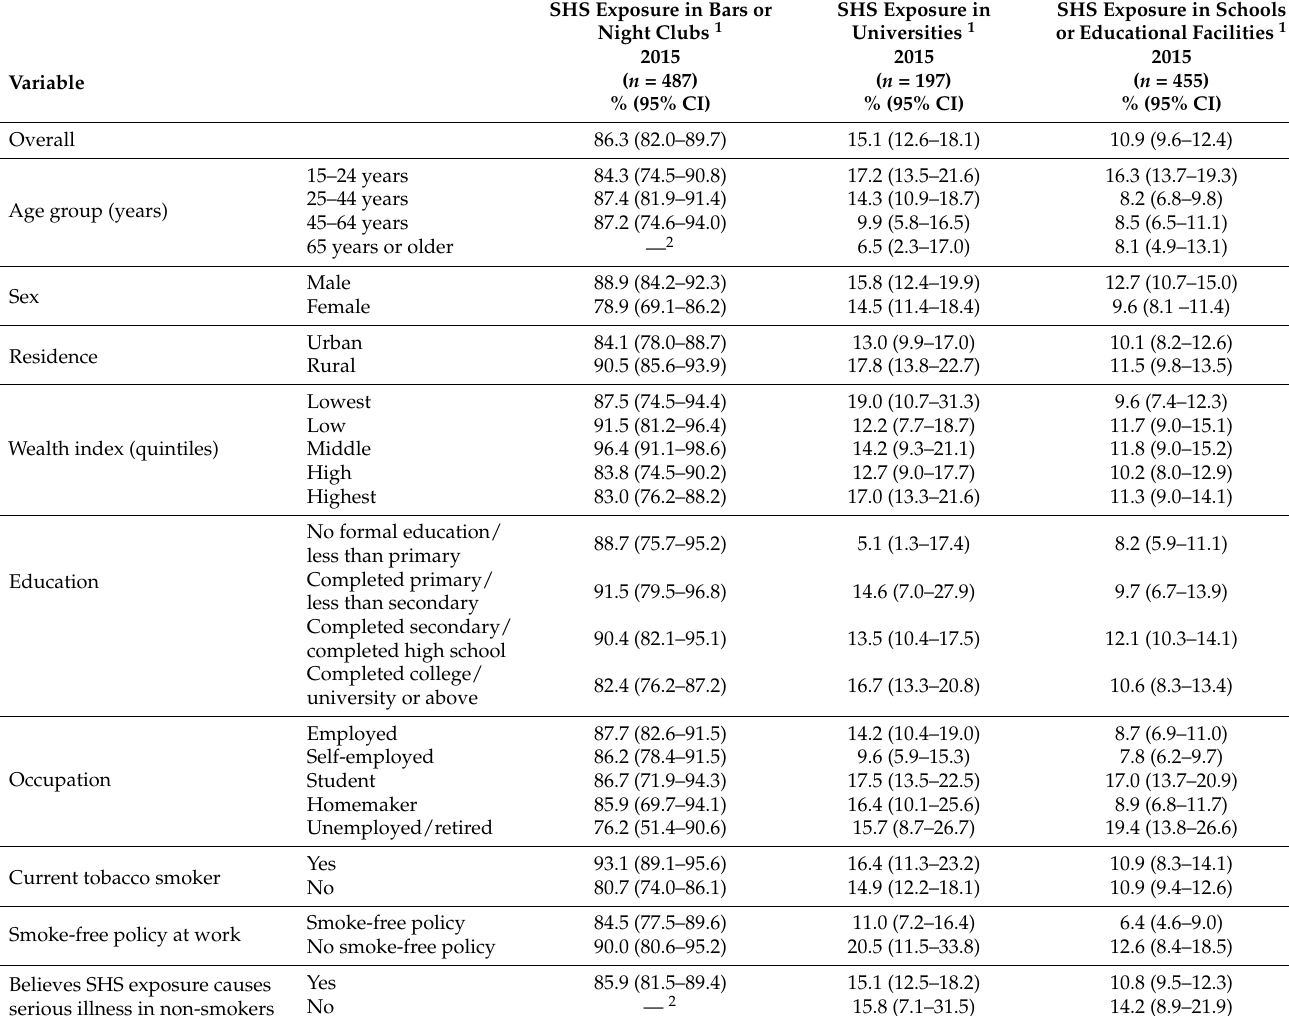
Table 3. Prevalence of SHS exposure by sociodemographic characteristics, tobacco use, and smoking policies among adults aged 15 years or older in the Philippines,